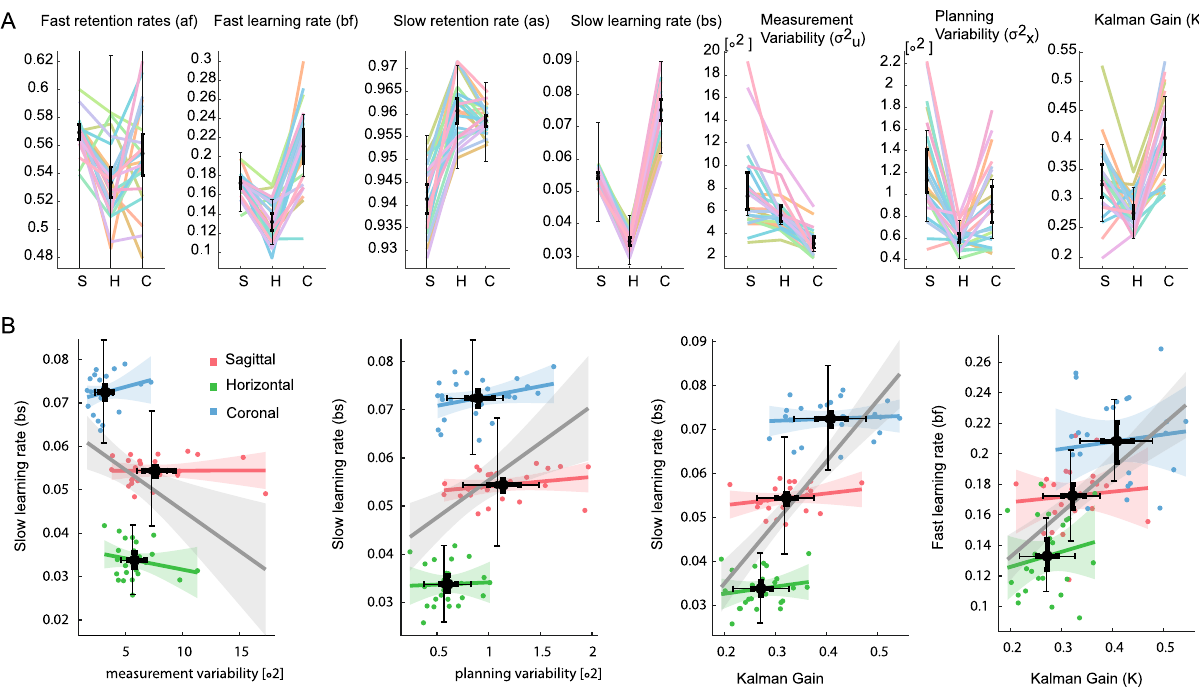
Figure 5. Comparison of two-state model parameters between the perturbation planes. ( A ) Estimated fast and slow retention ( a f , jp , a s , jp ), learning rates ( b f , jp , b s , jp ), and measurement and planning variabilities ( σ x , jp , σ u , jp ) for the sagittal (S), horizontal (H) and coronal (C) perturbation planes. Each color represents one subject. The error bars correspond to 95% credible intervals (i.e., contain 95% of the posterior probability) for the population , µ , µ , µ , µ σ , µ σ average hyper-parameters µ a . The steady-state Kalman gain K was a f , p b s , p b f , p s , p x , p u , p computed from the posteriors of the measurement noise and planning noise. ( B ) Relationships between the slow learning rate bs and variability related parameters: measurement noise variability, planning noise variability, and steady-state Kalman gain. Points correspond to individual subjects’ parameters in the different rotation planes (coded by color). The correspondingly colored lines represent linear fits based on the across-subject parameter values within each plane. The grey line corresponds to a linear fit based on subjects’ parameters values across all planes. The horizontal and vertical error bars correspond to 95% credible intervals for the corresponding parameter population average